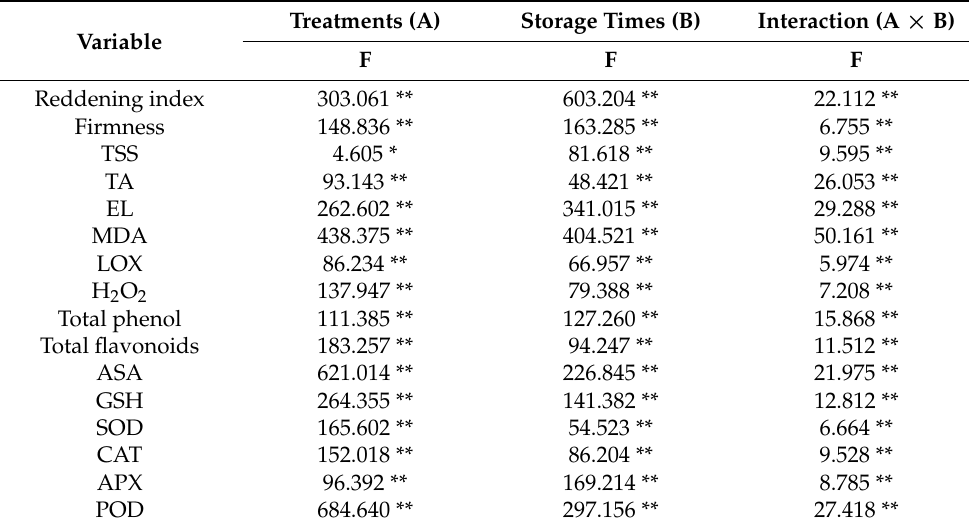
Table 1. Two-way ANOVA of treatments and storage times for winter jujube after